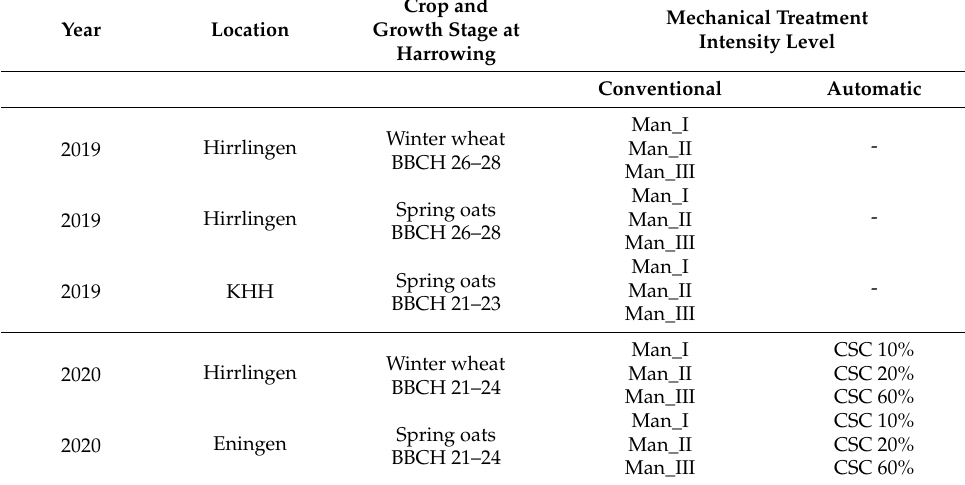
Table 2. Overview of the harrowing treatments with their different intensity level, and relative crop stage at harrowing in the experiments in spring oats and winter wheat in Hirrlingen, KHH, and Eningen in 2019 and 2020. Man_I = low conventional adjustment of tine angle (10 ◦ ); Man_II = medium conventional adjustment (tine angle 40 ◦ ); Man_III strong conventional adjustment (tine angle 70 ◦ ); CSC 10% = threshold for automatic adjustment with 10% crop soil burial; CSC 20% = threshold for automatic adjustment with 20% crop soil burial; CSC 60% = threshold for automatic adjustment with 60% crop soil